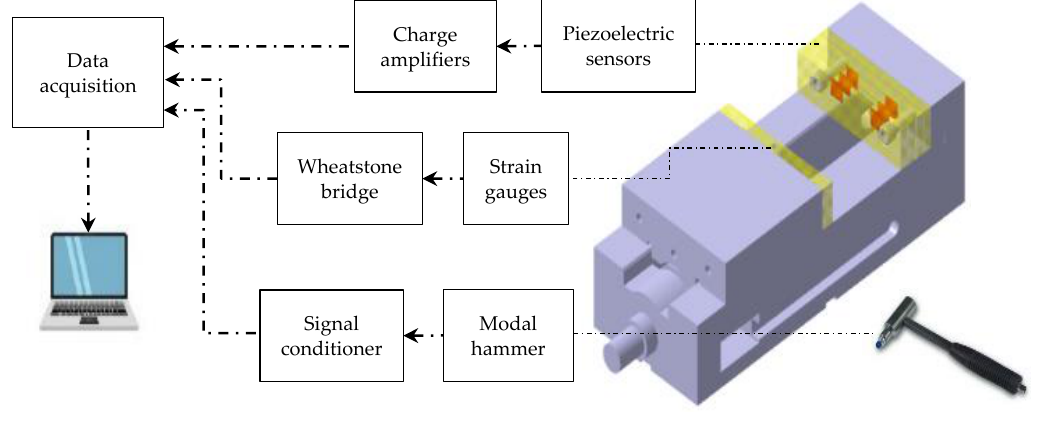
Figure 13. Schematic of calibration tests.